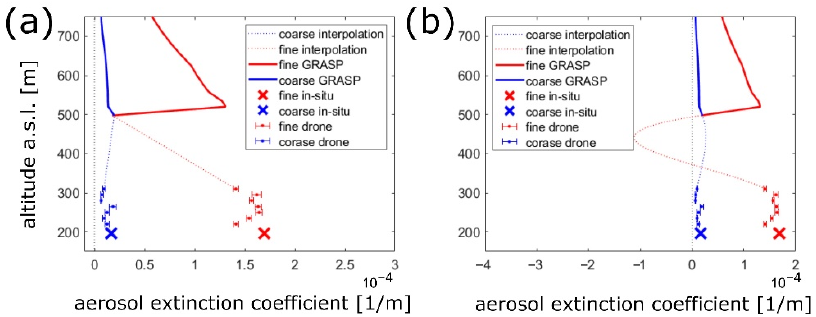
Figure 2. Examples of unsatisfactory interpolation attempts results from a mismatch between in- situ extinction measurements and the value retrieved by GRASP at the lowermost profile point. The subplot ( a ) depicts a linear interpolation while the subplot ( b ) shows the result of application of third order polynomial function with an enforced continuity of values and first derivatives at the boundaries.